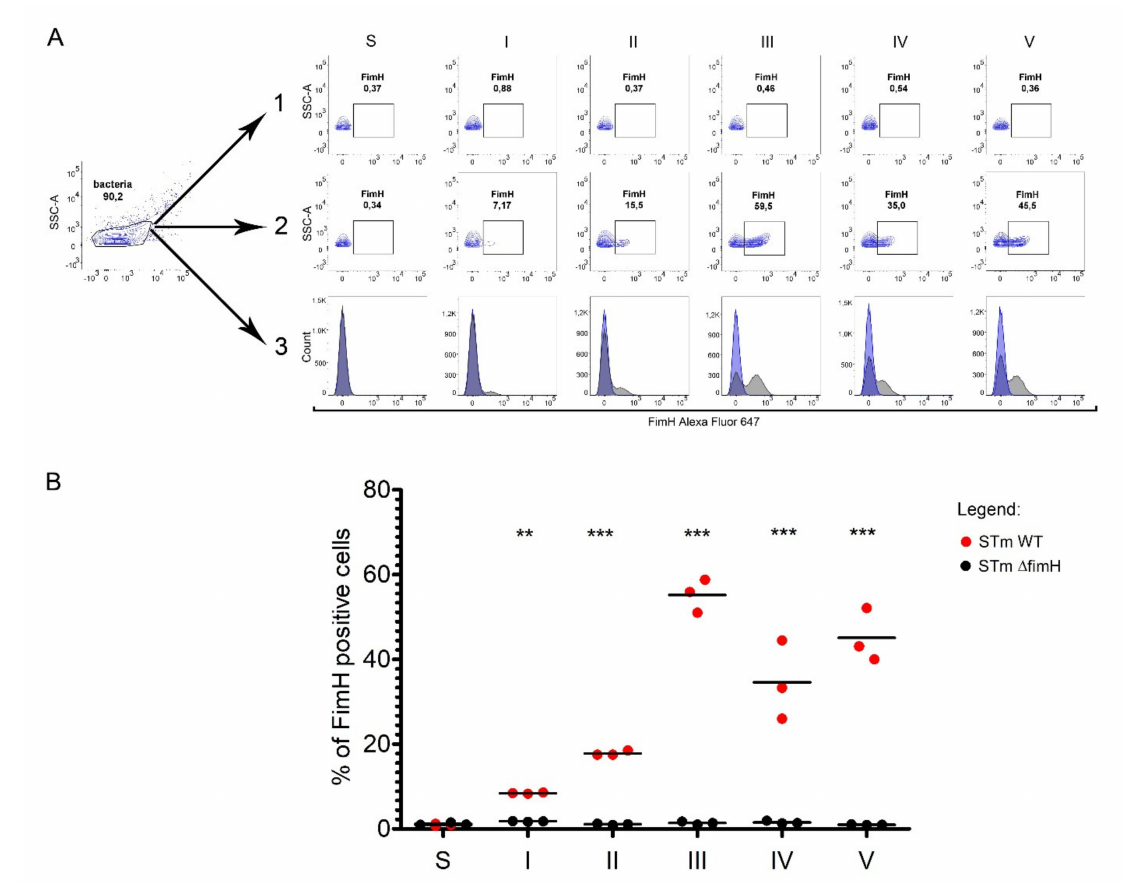
Figure 3. FimH protein expression on the surface of Salmonella Typhimurium depends on growth conditions. ( A ) Representative dot plots for the gating strategy of FimH positive: (1) STm ∆ fimH and (2) STm WT after growth on solid agar (S) or after five serial passages (I-V) in a liquid medium without agitation. (3) Representative overlay histograms of STm WT (grey histograms) and STm ∆ fimH (blue histograms). ( B ) Percentage of FimH positive STm ∆ fimH (black dots) and / or STm WT (red dots) after growth on solid agar (S) or after five serial passages (I-V) in a liquid medium without agitation measured by flow cytometry. Data represent the mean ± SD of three independent experiments. Statistical di ff erences between STm ∆ fimH and STm WT were analyzed with Student’s t -test and are presented as individual values with a mean. ** p < 0.01, and *** p <